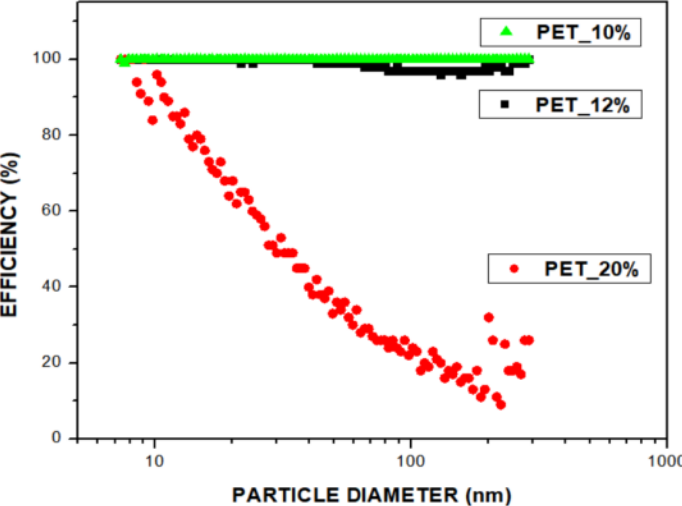
Figure 4. Efficiency curves for samples with filtration velocity equal to 4.8 cm s − 1 and particle diameter distribution ranging from 7 to 300 nm.